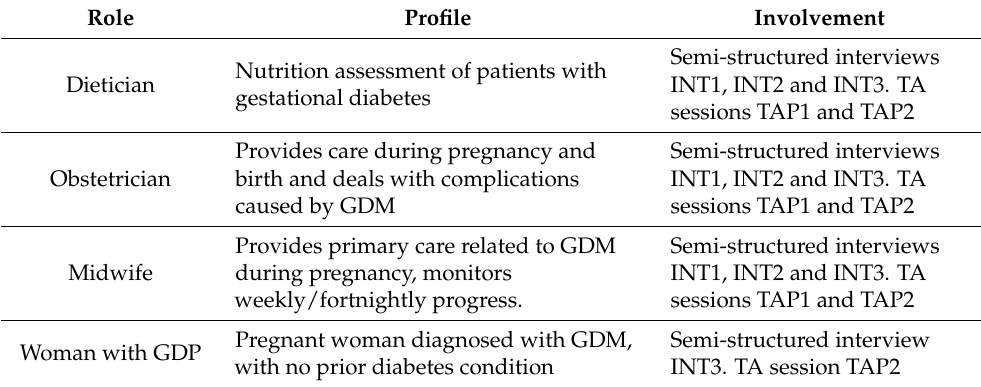
Table 1. Study sample characteristics and participant involvement.